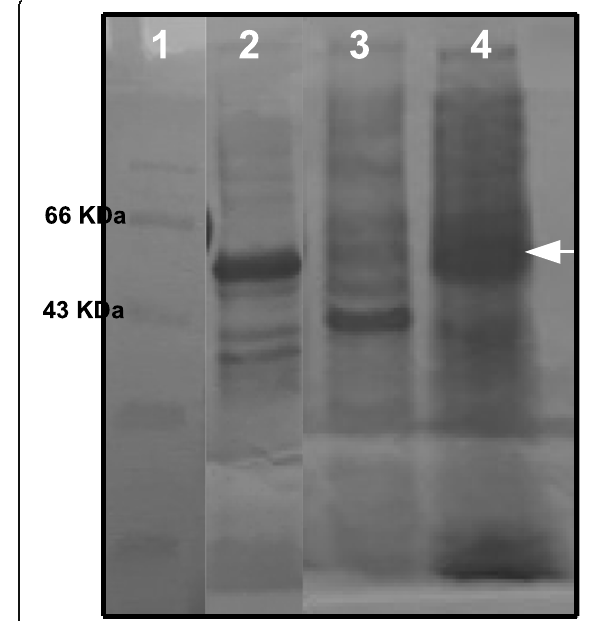
Fig. 5 Cellulase expression with increased solubility. Lane 1, protein marker; lane 2, pellet of cell lysate; lane 3, pellet (inclusion body) of slow induction; lane 4, supernatant (soluble fraction) of slow induction with arrow showing hyper expressed cellulase